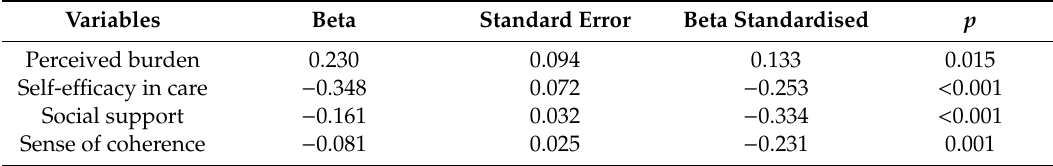
Table 3. Multiple linear regression by steps (dependent variable: depressive symptoms).